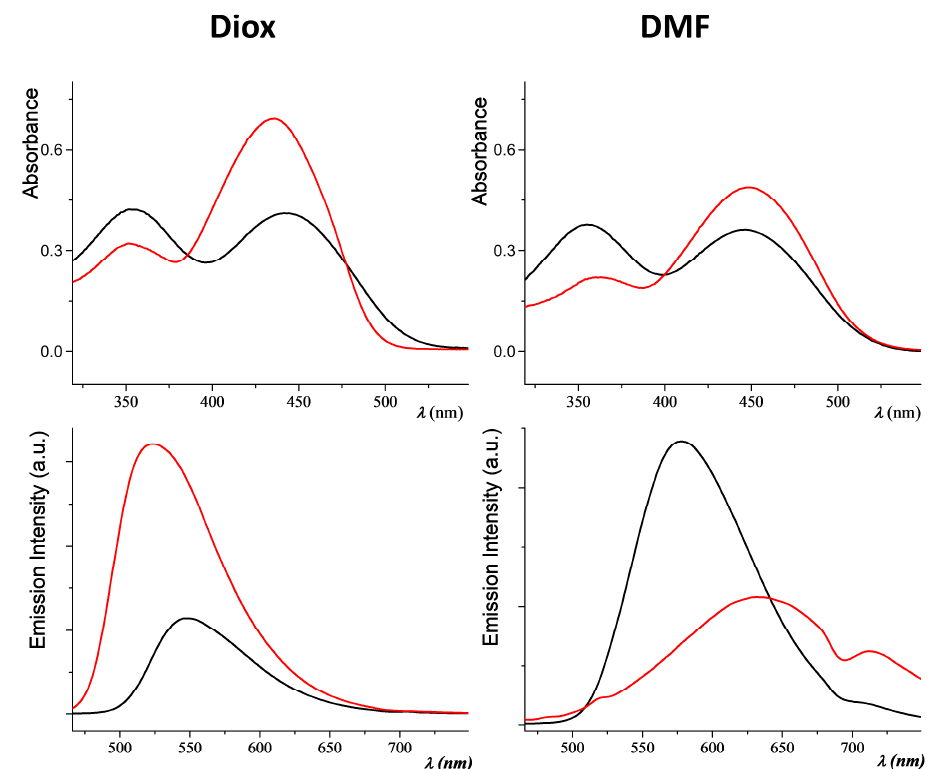
Figure 1. Absorption (up) and emission (down) spectra of C1 (red line) and C2 (black line) in dioxane ( left ) and DMF ( right ) solution.